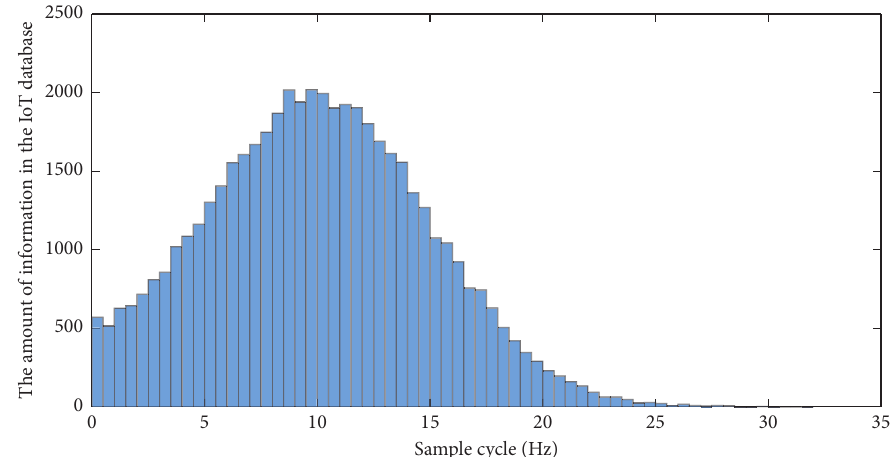
Figure 6: Information distribution of Internet of Things